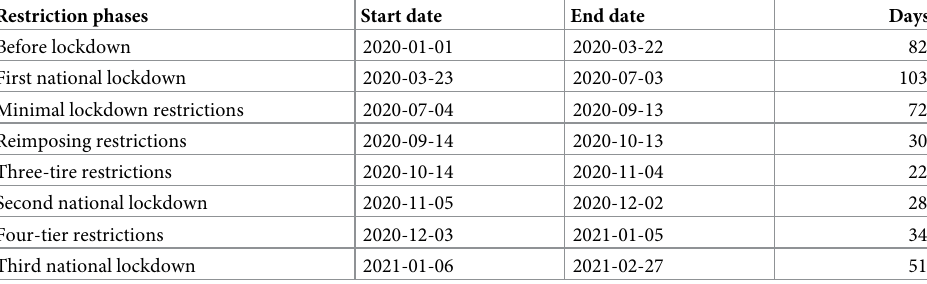
Table 1. The eight policy restriction